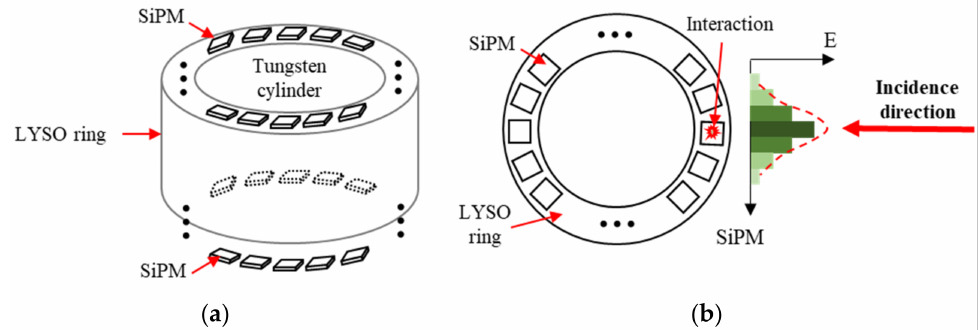
Figure 1. ( a ) Structural diagram of the gamma radiation sensor. ( b ) Illustration of the method used to measure the direction of the incoming gamma